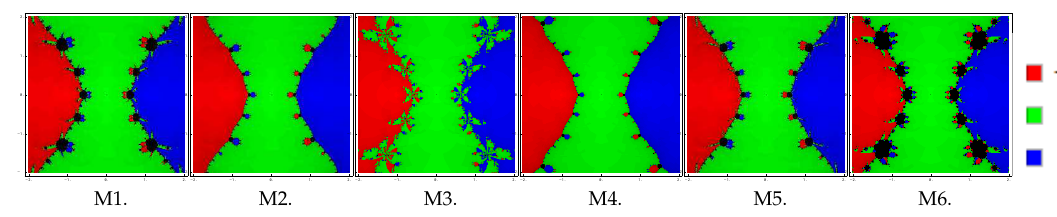
Figure 5. Basins of attraction for polynomial P 2 ( z ) for β = 10 − 4 .